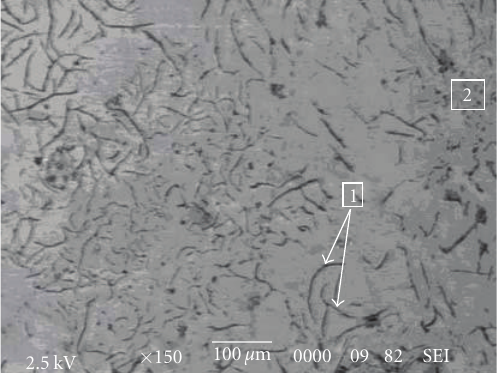
Figure 6: Co3 electron micrograph showing graphite (1) and γ Fe/C eutectic